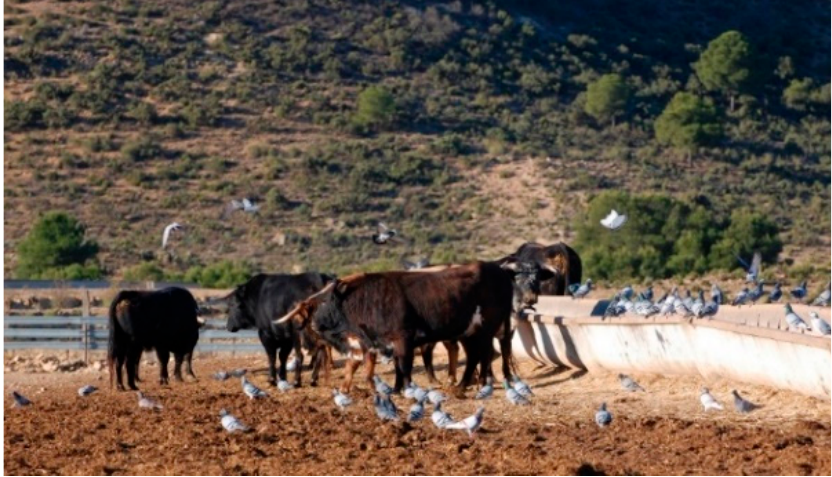
Figure 1. Fighting bulls sharing habitat with pigeons. Pigeons step and peck in the stool areas of the bulls and perch on the feeders .